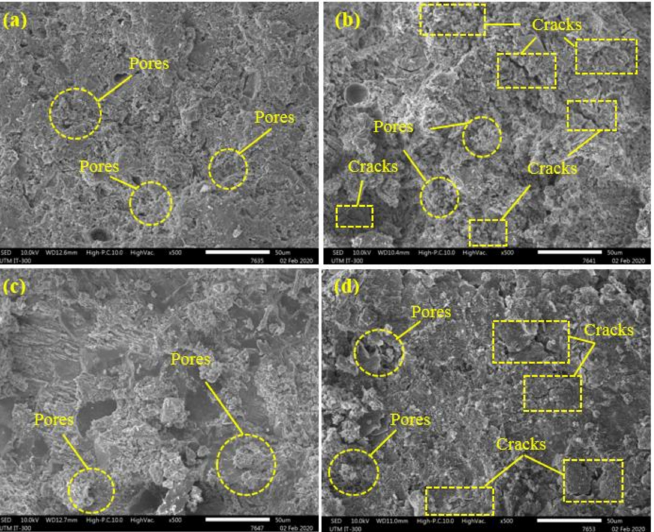
Figure 13. SEM image of control and GBFS modified concretes exposed to elevated temperatures ( a ) control specimen at 500 ◦ C ( b ) control specimen at 900 ◦ C ( c ) GBFS modified at 500 ◦ C ( d ) GBFS modified at 900 ◦